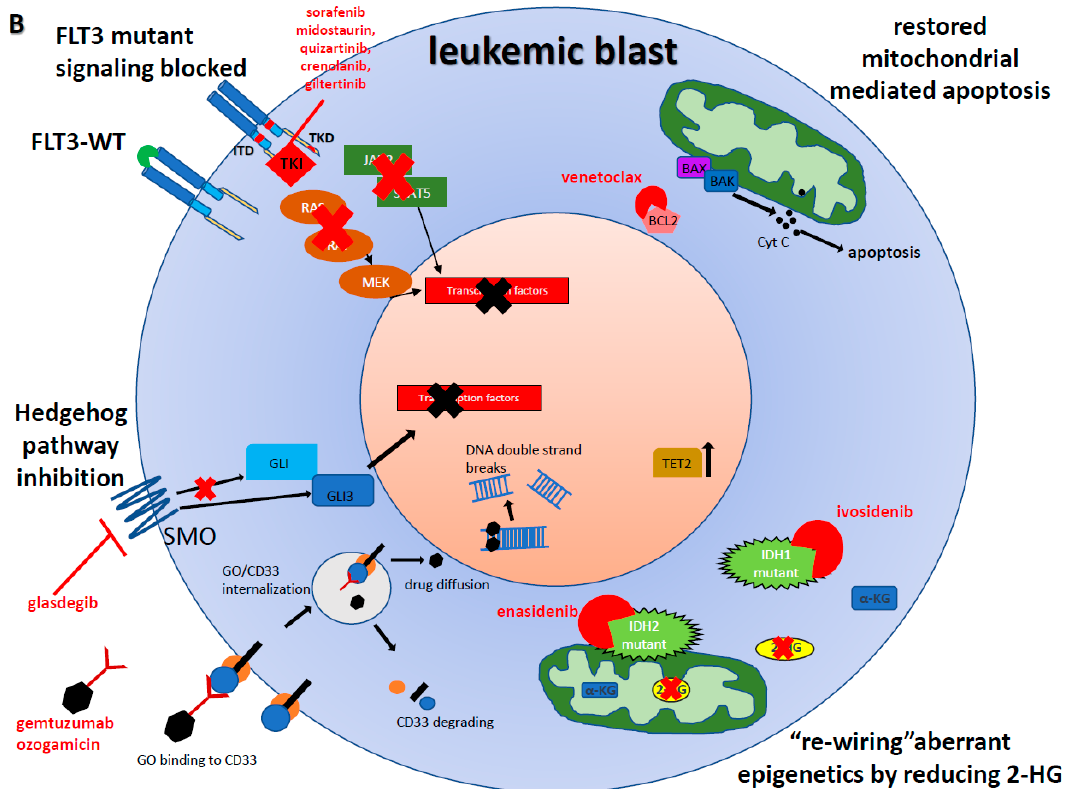
Figure 1. ( A ) Schematic illustration of aberrant and potentially druggable signalling in leukemic blasts leading to cellular proliferation and survival advantage in acute myeloid leukemia (AML). ( B ) Targets cell death.